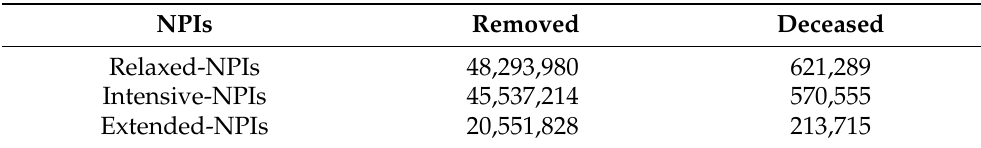
Table 2. Historical strain and Alpha variant development without vaccination. Cumulative numbers of individuals removed and hospital deaths on 30 June 2022.